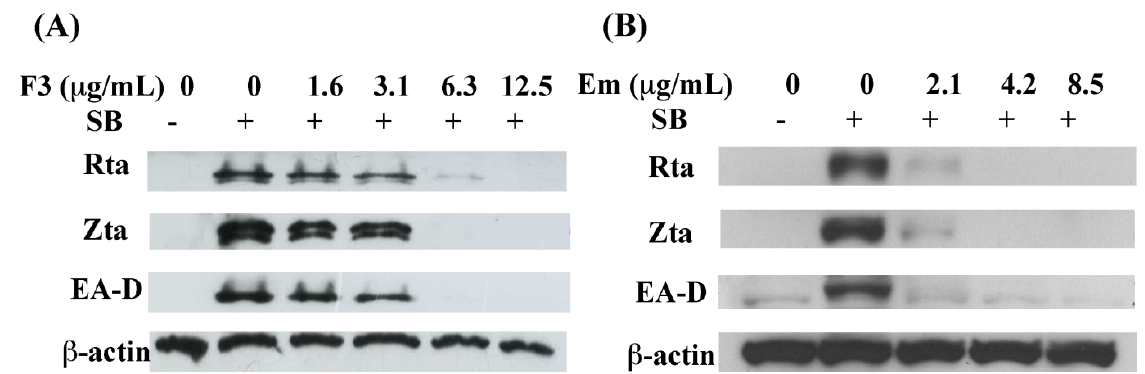
Figure 3. Inhibitory effects on the expression of EBV lytic proteins, including Rta, Zta and EA-D by F3 and emodin. The F3 ( A ) or emodin (Em) ( B ) was added to P3HR1 cells induced by sodium butyrate (SB). Syntheses of Rta, Zta and EA-D by EBV were studied by immunoblot analysis at 24 h after lytic induction with anti-Rta, anti-Zta, anti-EA-D and anti- β -actin